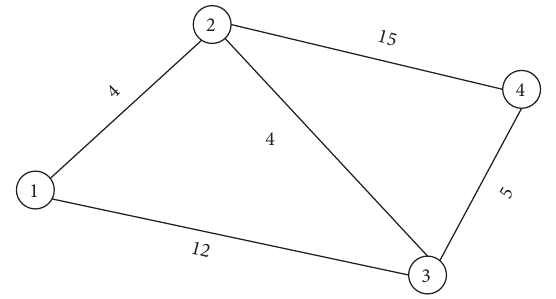
Figure 1: A small network with four nodes.